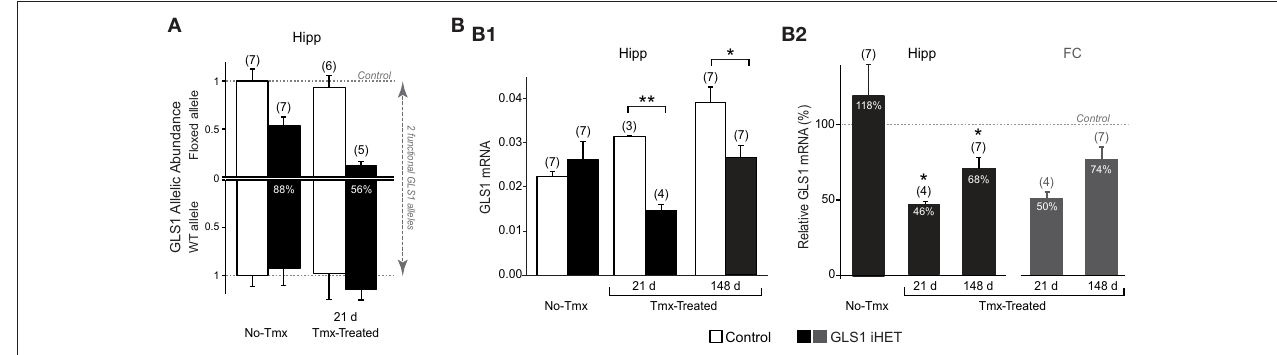
FIGURE 3 | Induction of GLS1 deficiency in the brain. (A) GLS1 allelic abundance. Wild type (WT) and floxGLS1 (Floxed) allelic abundance in one hippocampus is plotted with respect to the allelic abundance in Control, Tmx-naïve (No-Tmx) mice. In Tmx-naïve GLS1 iHET mice, the floxed allele abundance was 0.54, while in Tmx-treated GLS1 iHET mice this went down to 0.12. The percent reduction in functional allelic abundance is indicated on the bars. (B) Relative GLS1 mRNA expression. (B1) In Tmx-naïve mice (No-Tmx), there was no genotypic difference in GLS1 mRNA expression in the hippocampus, while in Tmx-treated mice, there was a significant main effect of genotype at both time points after Tmx injection (21 days and 148 days). **indicates p < 0.001 * indicates p < 0.05 . (B2) mRNA values for the hippocampus (Hipp) in GLS1 iHET mice were expressed as the percentage of control values for each condition (dashed line). There was no reduction in Tmx-naïve mice, whereas in Tmx-treated mice relative mRNA expression was reduced at both 21 and 148 days post-Tmx. * statistically different from No-Tmx GLS1 iHET mice, p < 0.05 . The relative mRNA values for the frontal cortex (FC) of Tmx-treated mice (dark gray bars) also showed a similar reduction, to 50 and 74%, 21 and 148 days post-Tmx,